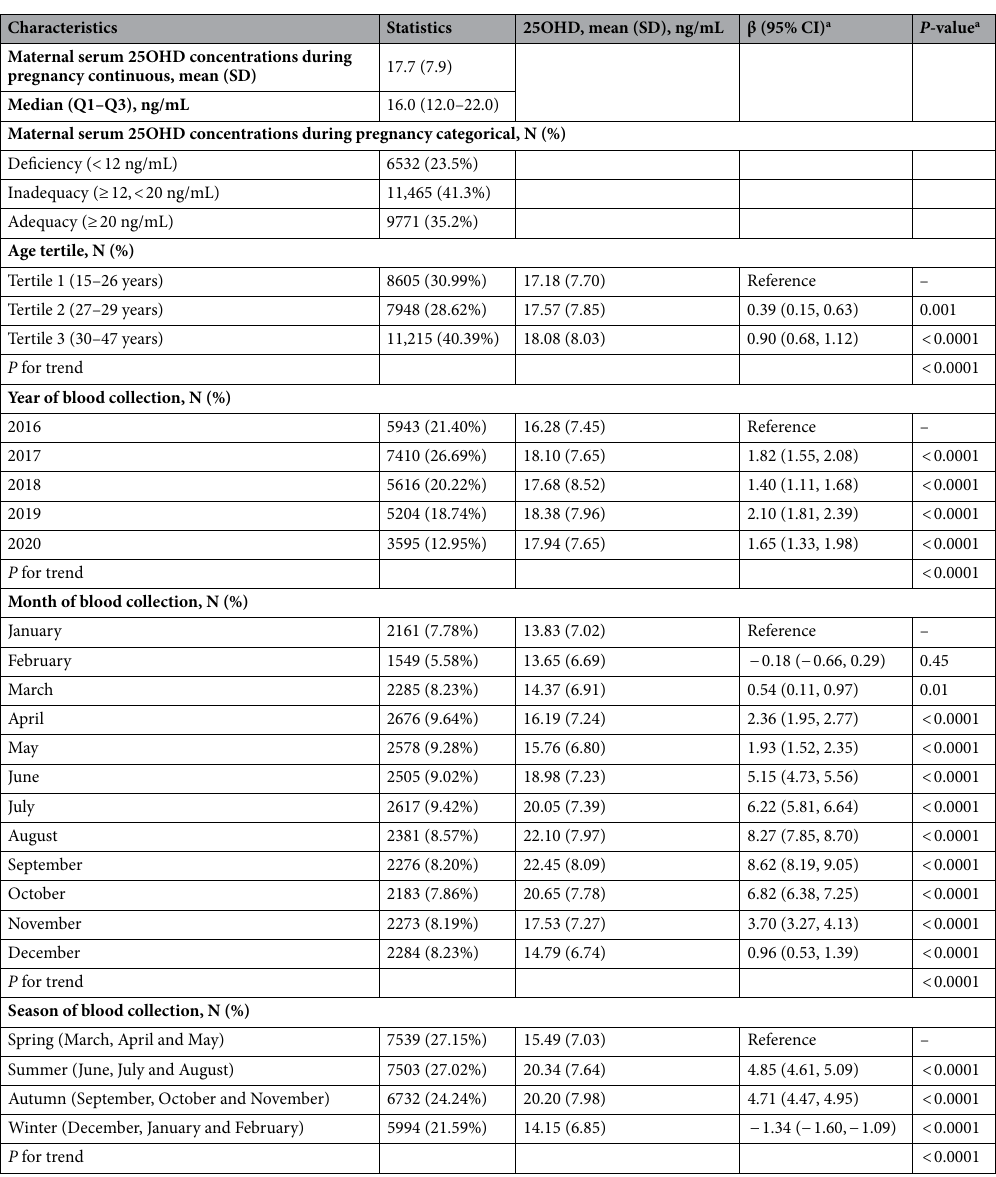
Table 1. Characteristics of study participants (N = 27,768). 25OHD 25-hydroxy vitamin D, OR odds ratio, CI confidence interval, SD standard deviation. a Crude associations with maternal serum 25OHD concentrations during pregnancy